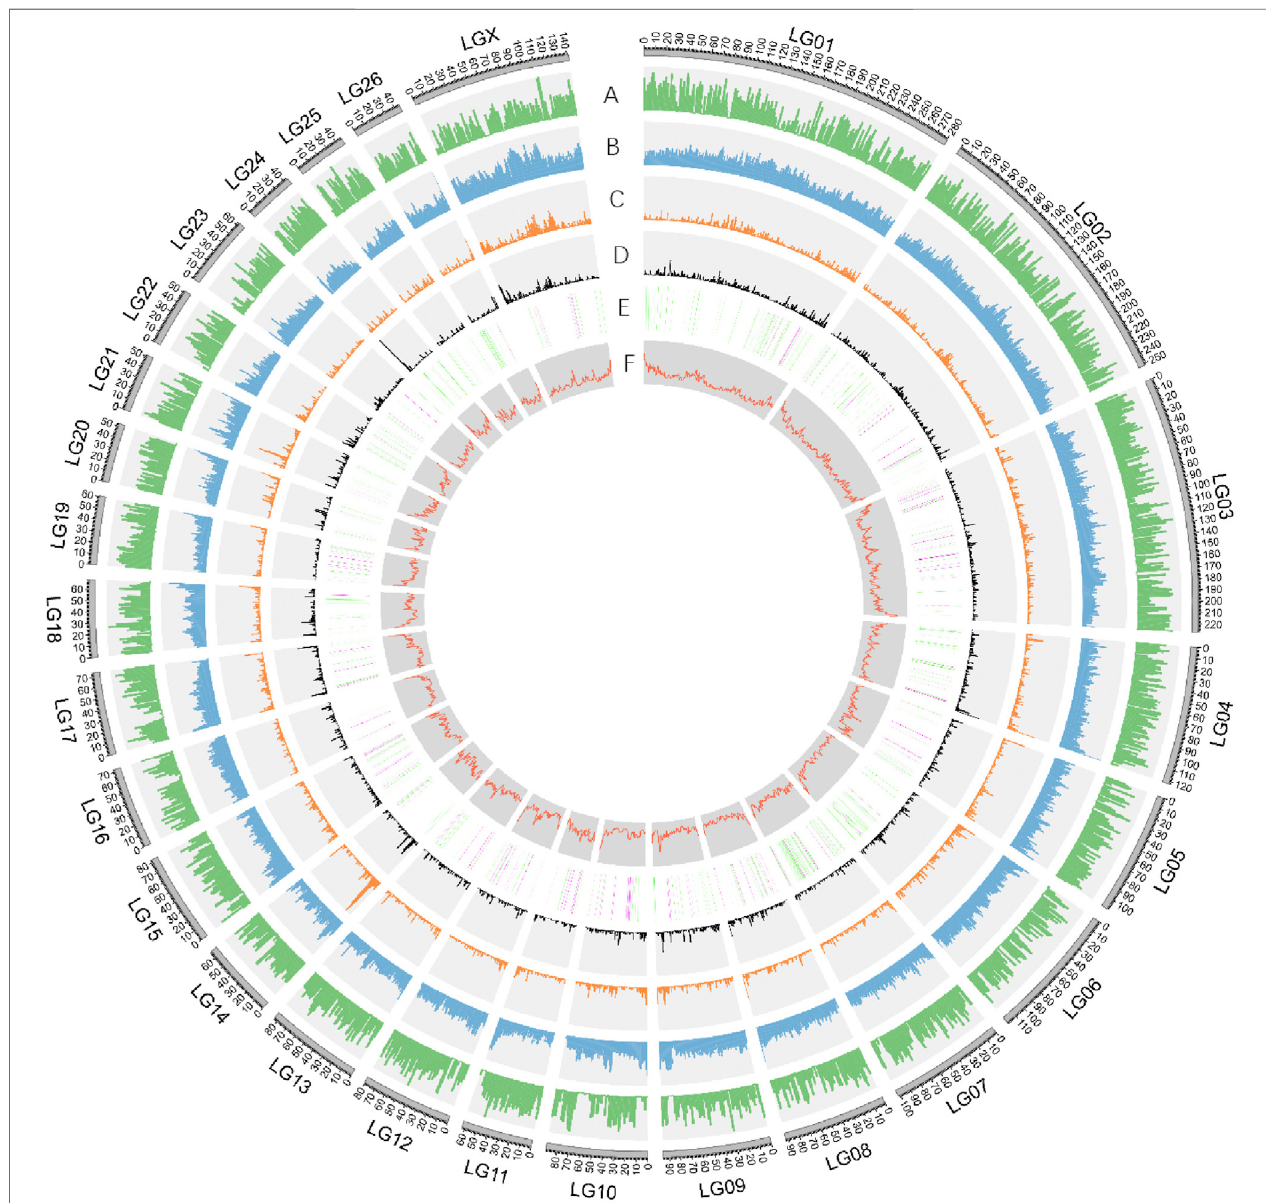
FIGURE 2 | Characterization of Dorper sheep genome. Circos diagram showing (outer to inner): A. Gene density (genes per 1 Mb window). B. Repeat density (repetitive sequence per in 1 Mb window). C. Gypsy-type LTR density.D. Copia-type LTR density. E.The numbers and distribution of ASE genes derived from DSS and PSS were represented in green and purple respectively. F. GC content in sliding windows of 1 Mb across each chromosome.